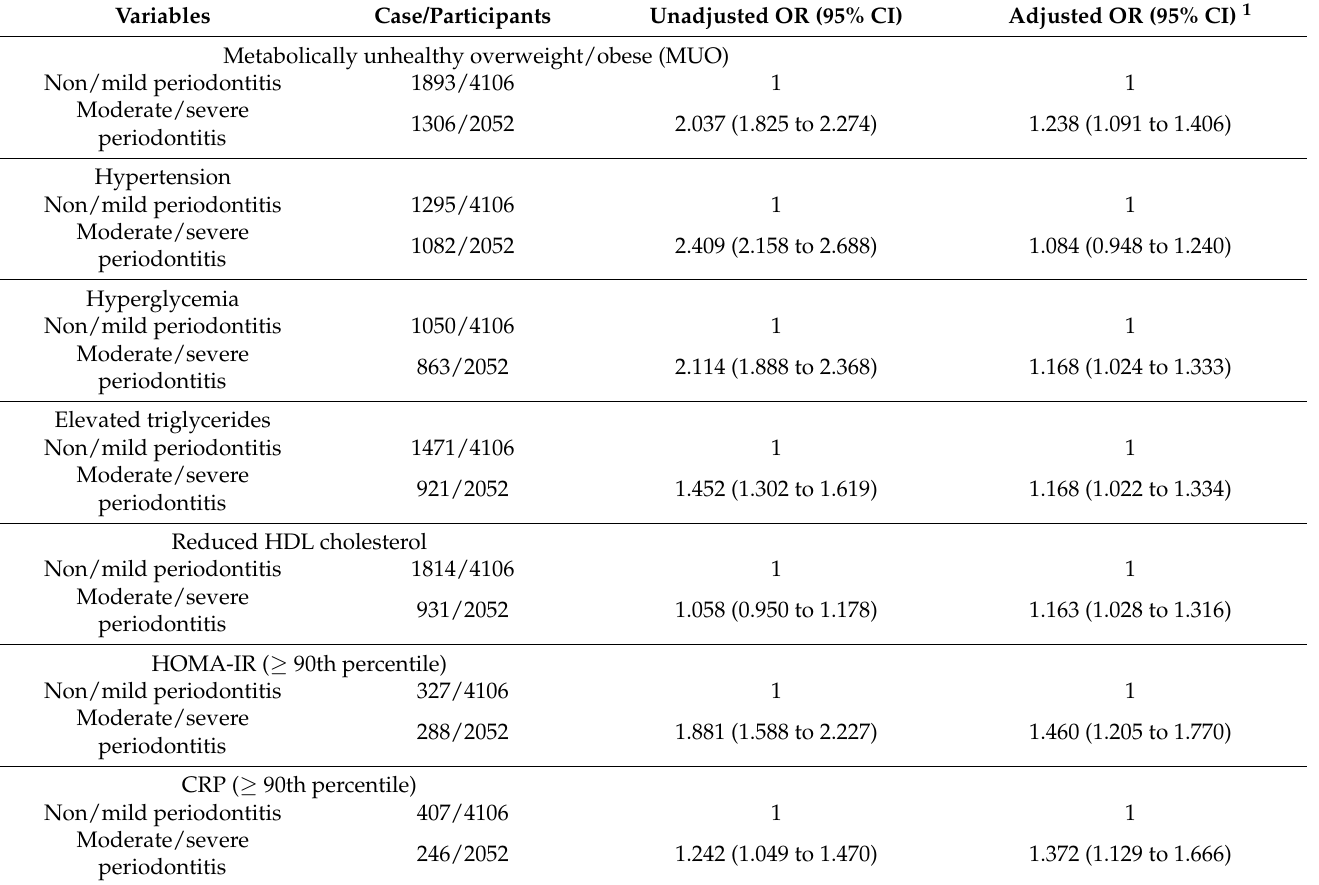
Table 2. Weighted associations of periodontitis with metabolically unhealthy overweight and obese phenotype and the individual components in the NHANES III